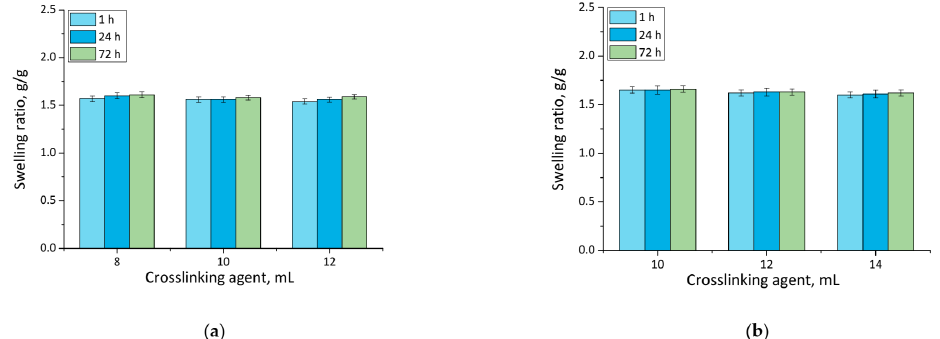
Figure 3. Swelling in SBF of unmodified hydrogels ( a ), and hydrogels modified with 10 mL of Equisetum arvense L. extract ( b ) (number of repetitions n =